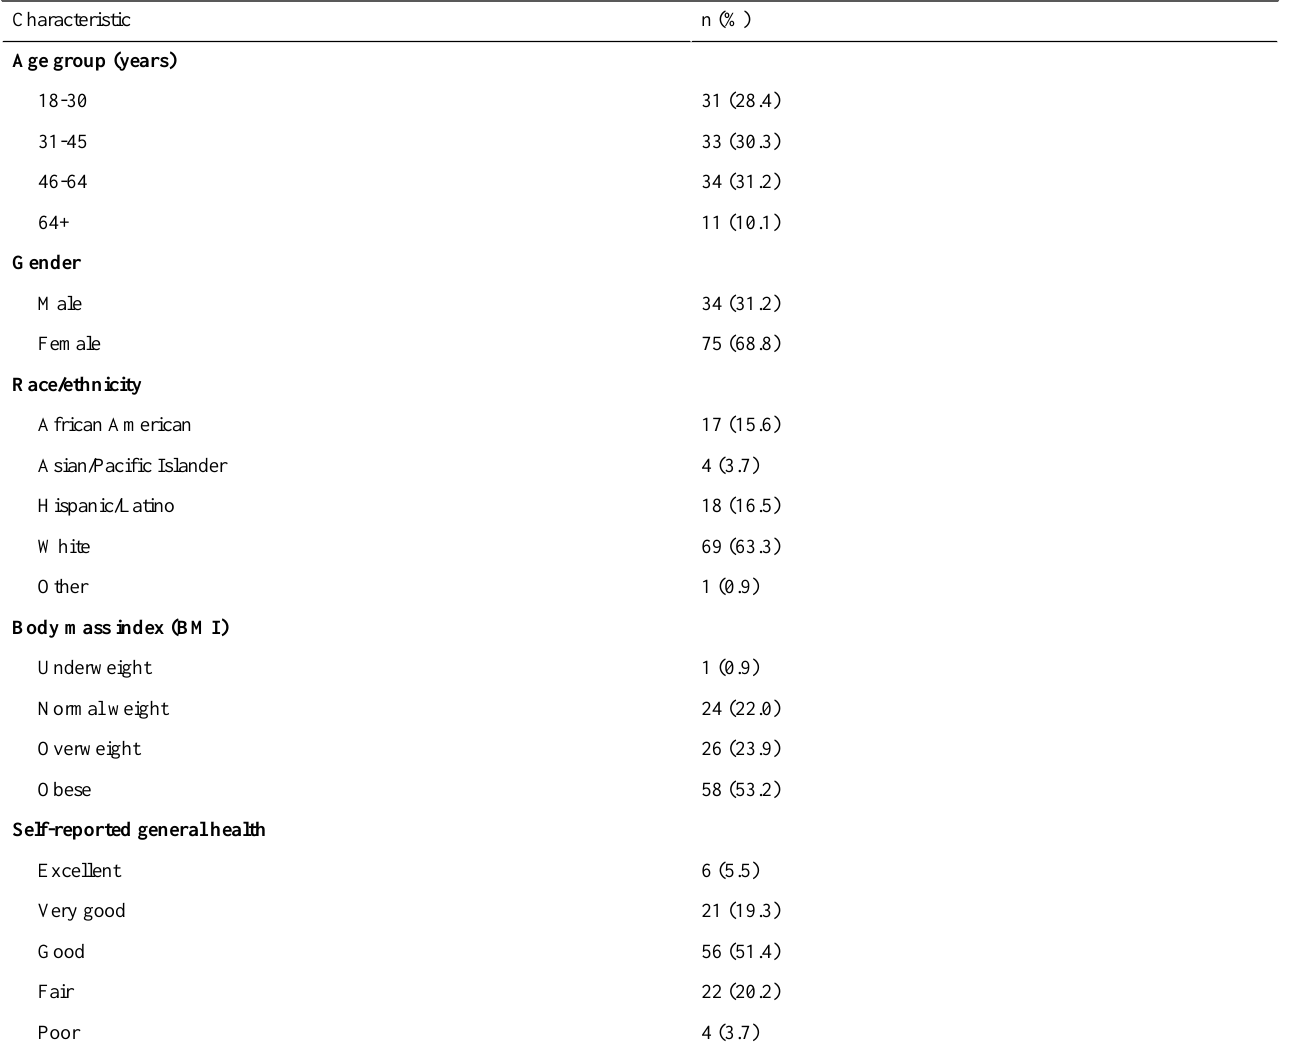
Table 2. Demographics and general health information of participants